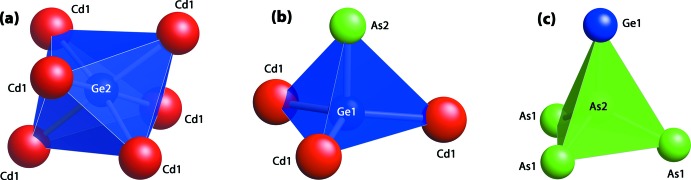
Coordinated atoms around Ge2, Ge1, and As2 are shown as (a) a Ge2(Cd1)6 octa­hedron, (b) a Ge1[(Cd1)3As2] tetra­hedron, and (c) an As2[(As1)3Ge1] tetra­hedron.